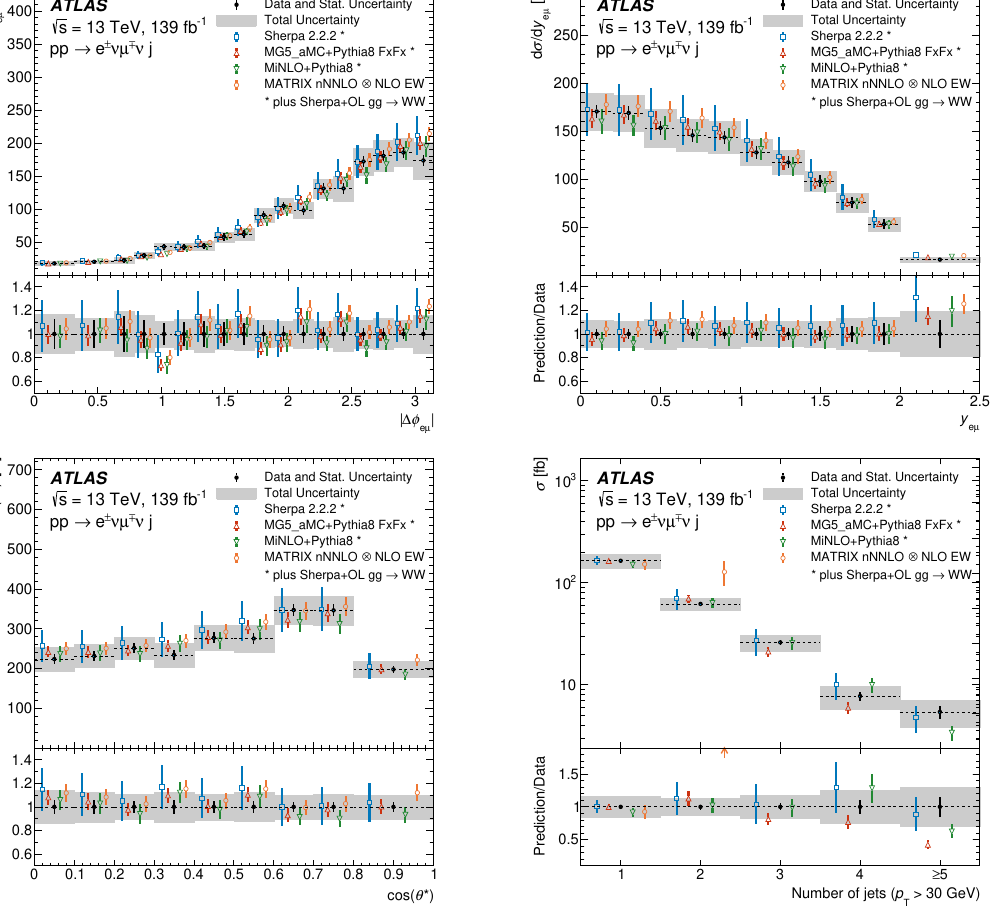
Figure 8 . Measured fiducial cross-sections of WW +jets production for (from left to right and top to bottom): ∆ φ ( e, µ ) , y , cos θ ∗ , and the exclusive jet multiplicity. The measured cross-section val- eµ ues are shown as points with error bars giving the statistical uncertainty and solid bands indicating the size of the total uncertainty. The results are compared with the NNLO prediction with extra NLO EW corrections and NLO corrections for gg → WW production (denoted MATRIX ⊗ NLO EW) as well as NLO+PS predictions from Sherpa 2.2.2, MadGraph5 _a MC@NLO + Pythia 8 with FxFx merging, and Powheg MiNLO + Pythia 8 for q ¯ q initial states, combined with Sherpa + OpenLoops (LO+PS) for the gg initial state. The Sherpa 2.2.2 + OpenLoops prediction is normalized to the total cross-section calculated at NLO in QCD. Theoretical predictions are indi- cated as markers with vertical lines denoting PDF and scale uncertainties.The MATRIX prediction is not defined for more than two jet